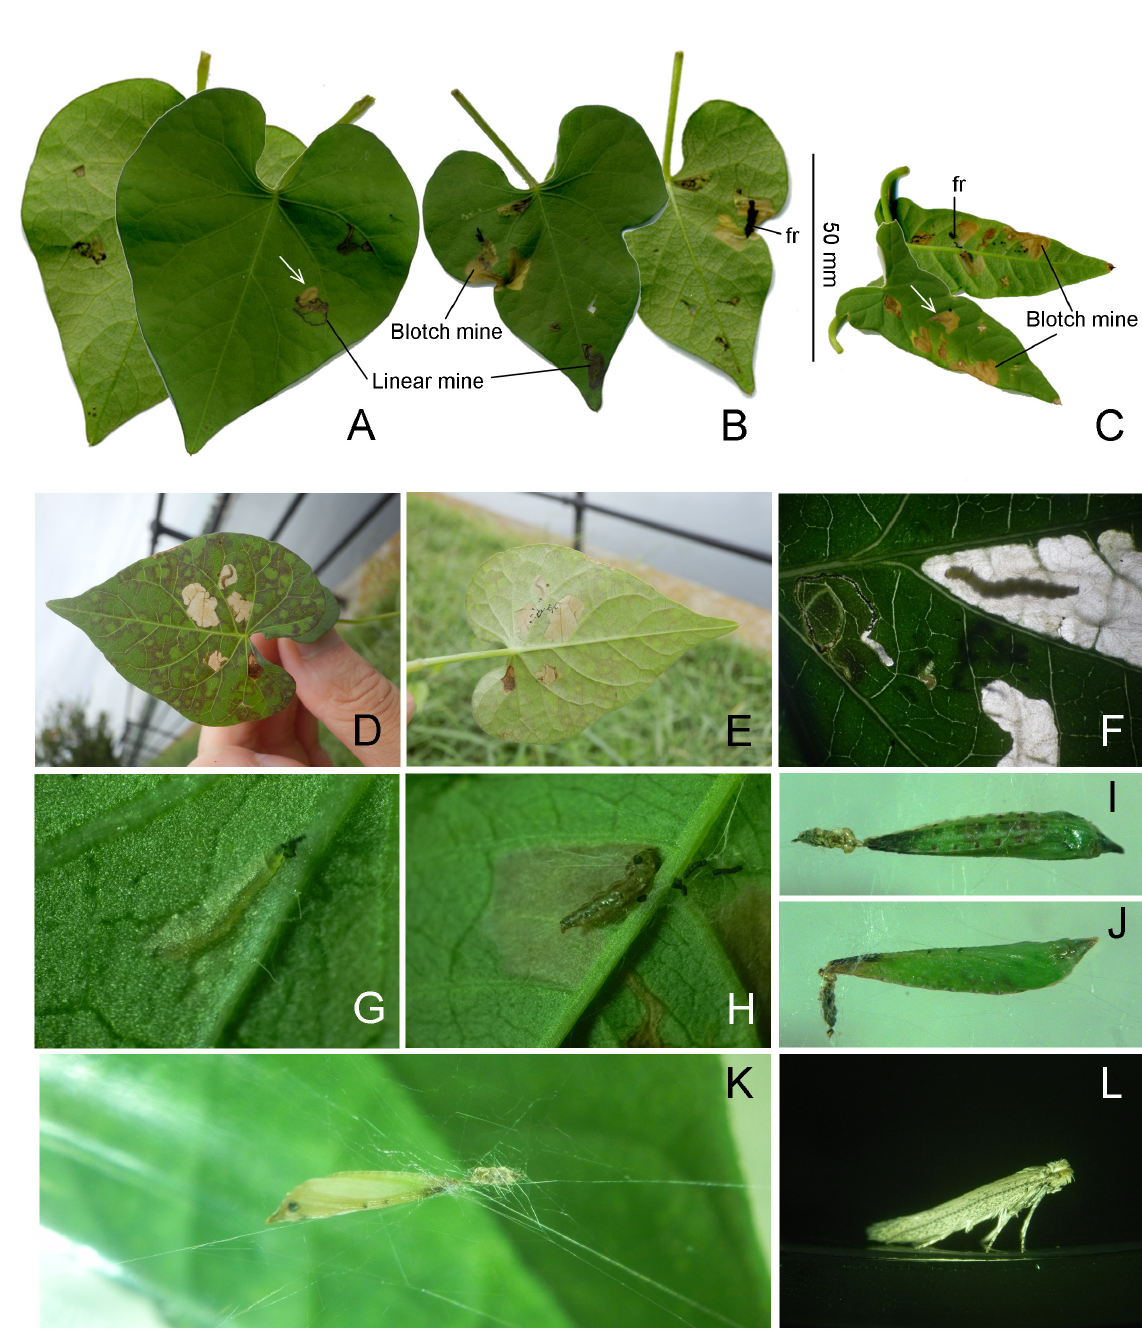
Fig. 15. Biology of Bedellia somnulentella Zeller, 1847, Bedelliidae Stainton, 1849, and its hostplants. A–B, D–L. Ipomoea sp. C. Calystegia sp. A–C . Leaves and mines. D . Blotch mines by later larva. E . Blotch mines and frass on abaxial side of leaf. F . Young larva and later larva. G . Later larva. H . Later larva forming new mine. I . Pupa, dorsal view. J . Lateral view. K . Pupa at the joint of some cross silken threads. Abbreviations: fr =